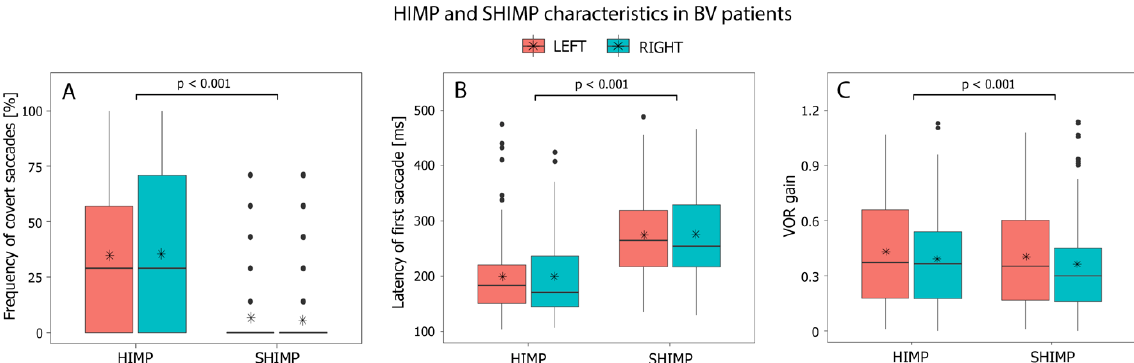
Figure 3. Characteristics of HIMP and SHIMP testing in BV patients for rightwards and leftwards head impulses: frequency of covert saccades ( A ), the latency of first saccade (covert and/or overt), ( B ), and VOR gain as calculated by a custom-made algorithm ( C ). Black horizontal lines represent median values; asterisks represent mean values for all patients.